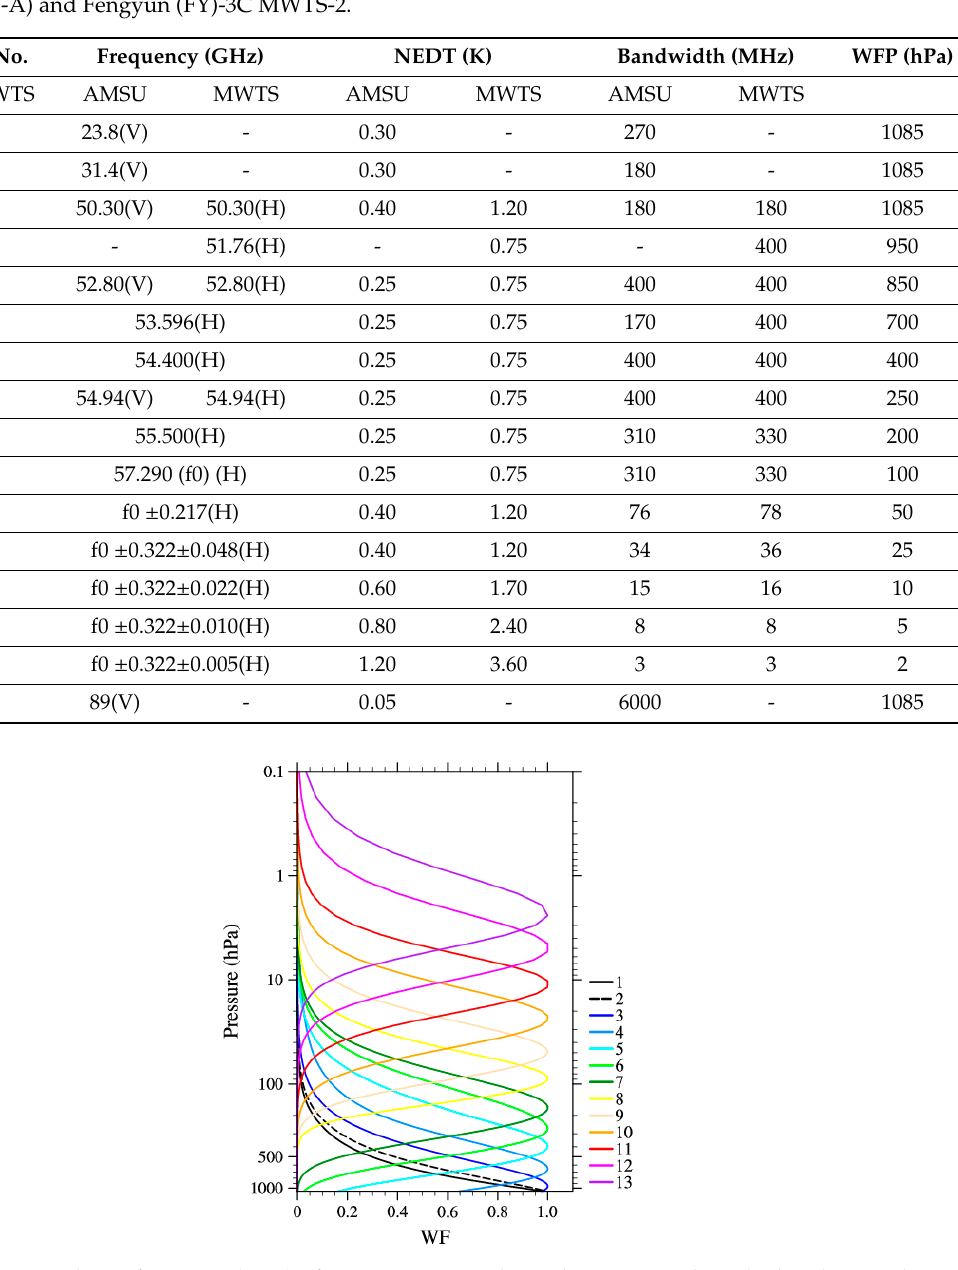
Figure 1. Weighting functions (WFs) of FY-3C MWTS-2 channels 1–13 at nadir, calculated using the community radiative transfer model (CRTM)(version 2.3.0) with the U.S. standard atmosphere profile.